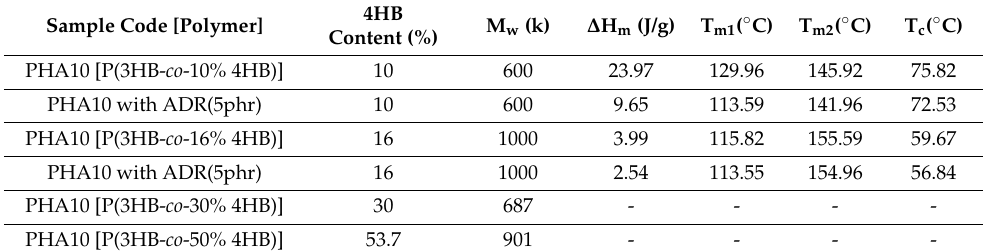
Table 1. Characteristics of P(3HB-co-4HB) used in this study.